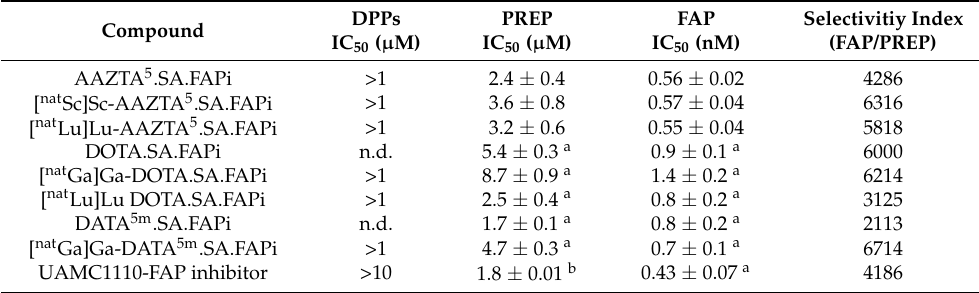
Table 1. IC 50 values of AAZTA 5 .SA.FAPi and DOTA.SA.FAPi derivatives for FAP and the related proteases DPPs and PREP. Data are presented as the mean with standard deviation ( n = 3 for FAP and PREP and n = 2 for the DPPs).